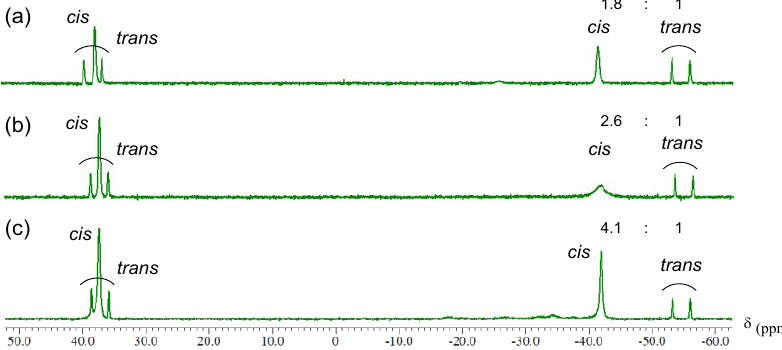
Figure 4. 31 P NMR spectra (162 MHz, CD 2 Cl 2 , ppm) of 5 at 20 °C ( a ), − 10 °C ( b ) , and −40 °C ( c ).